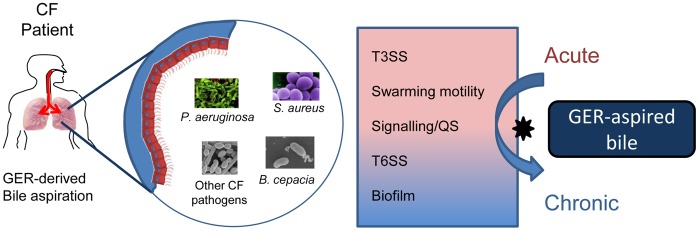
GER-derived bile may influence respiratory pathogen behaviour and biodiversity in the CF pulmonary system.Bile aspiration linked to GER is highly prevalent in CF patients and has been linked to reduced pulmonary function in these patients. As bile is shown to influence key phenotypes associated with chronic infection in P. aeruginosa, GER-derived bile may constitute a major host factor in chronic respiratory disease. Bile induces biofilm formation, T6SS, and QS in P. aeruginosa, while T3SS and swarming motility are repressed. The transcriptional and phenotypic changes are consistent with a switch towards the chronic lifestyle adopted by P. aeruginosa and other respiratory pathogens in the CF lung. Bile also influences biofilm formation in other respiratory pathogens prevalent in CF patients suggesting that GER-derived bile may influence biodiversity in the CF lung.